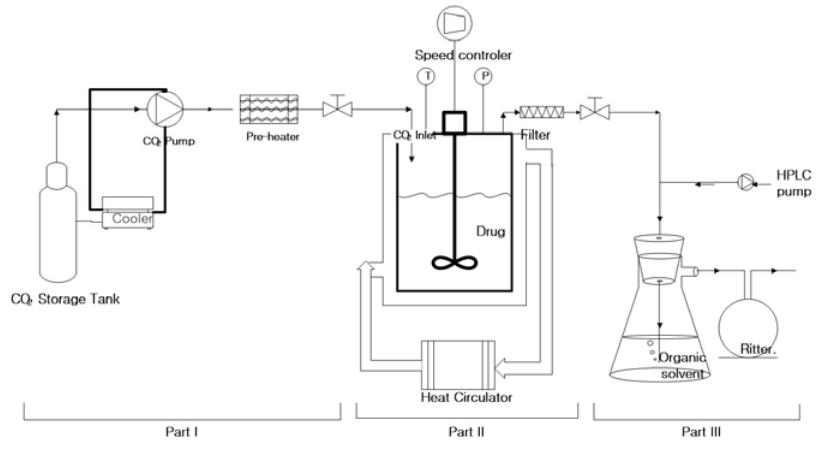
Figure 2. Schematic diagram of the apparatus for measurement of solubility in SC-CO 2 .